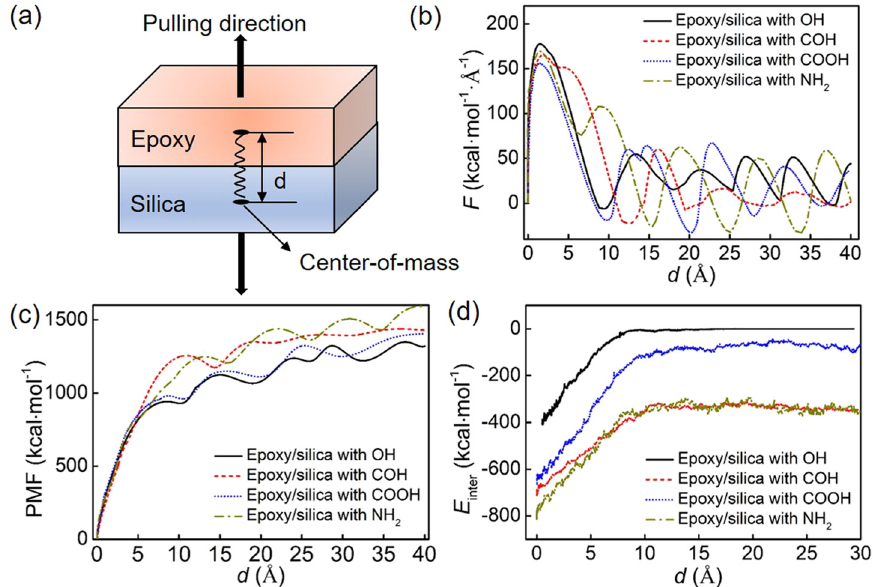
Figure 7: ( a ) The schematic diagram of pulling for epoxy/silica systems. ( b ) The curve of pulling force as a function of pulling displacement. ( c ) The curve of PMF as a function of pulling displacement. When the PMF reaches the fi rst peak, the pulling force can be negligible indicating the failure of the interface. ( d ) The curve of interfacial interactions ( E inter ) as a function of pulling displacement for di ff erent systems during